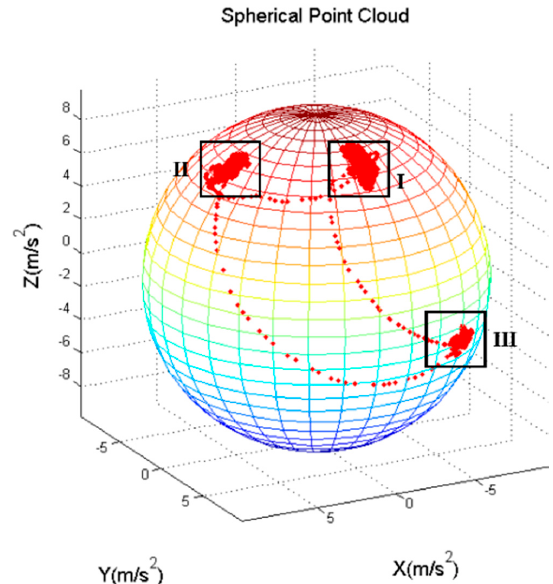
Figure 5. Spherical Point Cloud.